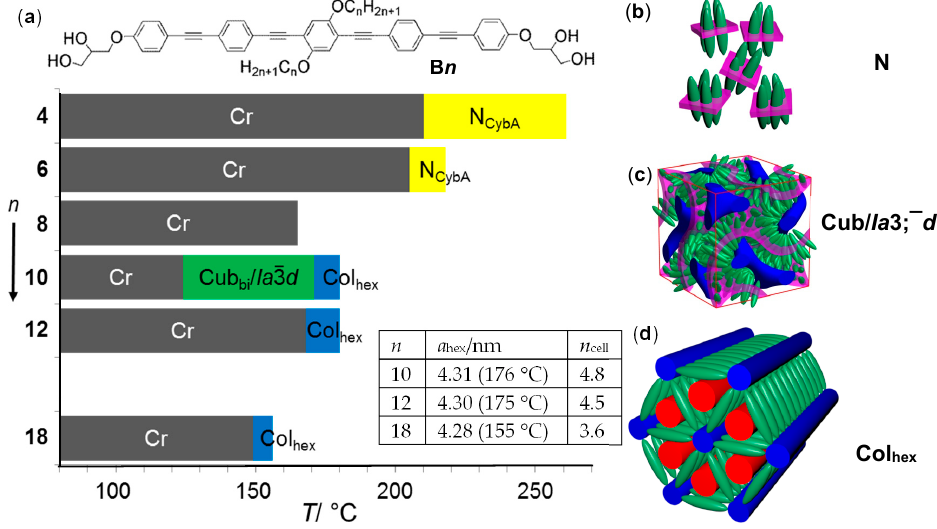
Figure 2. ( a ) Bar diagram showing the phase sequences of compounds B n , depending on the alkyl chain length n , as recorded on cooling with a rate of 10 K · min − 1 ; the hexagonal lattice parameter a hex , and the number of molecules in a unit cell ( n cell ) with a height h = 0.45 nm, corresponding to the maximum of the diffuse wide angle scattering, are shown for compounds B10 , B12 , and B18 [46]; abbreviations: N = nematic LC phase; Col hex = hexagonal columnar phase with p 6 mm plane group, representing a triangular LC honeycomb; Cub/ Ia 3;¯ d = bicontinuous cubic phase with Ia 3;¯ d space group (gyroid); Cr = solid crystalline state; the isotropic liquid state (Iso) is at the right side of the bars; ( b – d ) shows models of the organization of compounds, B n , in the distinct LC phases; the OPE rods are shown in all cases in green, whereas networks/columns of the glycerol groups (blue) and the lateral lipophilic chains (red) are only shown if they form long range ordered domains in ( c , d ); magenta indicates the minimal surface in ( c ) and the local smectic clusters in the (cybotactic) N phase in ( b ); ( d ) shows a structure with n cell = 3, corresponding to n wall = n cell /3 = 1 [46]. In the nematic phase, there is only orientational order of the OPE cores, i.e., all three molecular